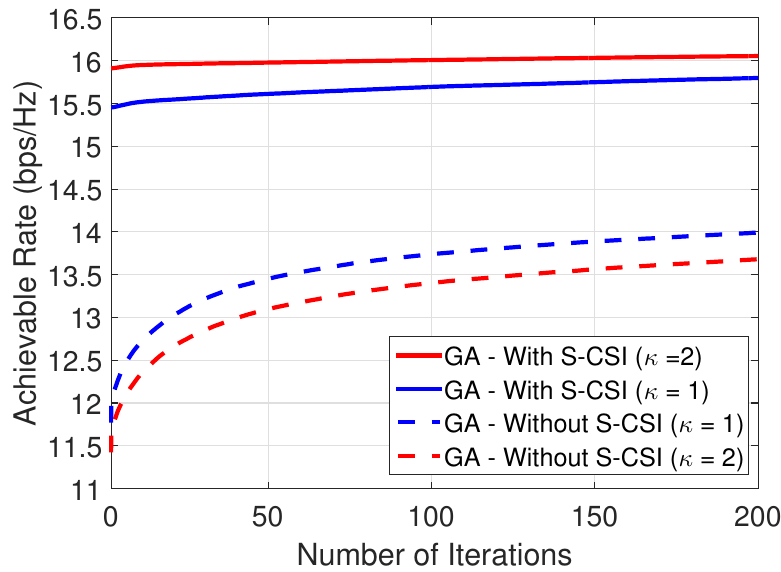
Figure 5. Convergence analysis for M = 80 and ( x u , y u ) = (75, 8) m, i.e., d IU ∼ 25 m.